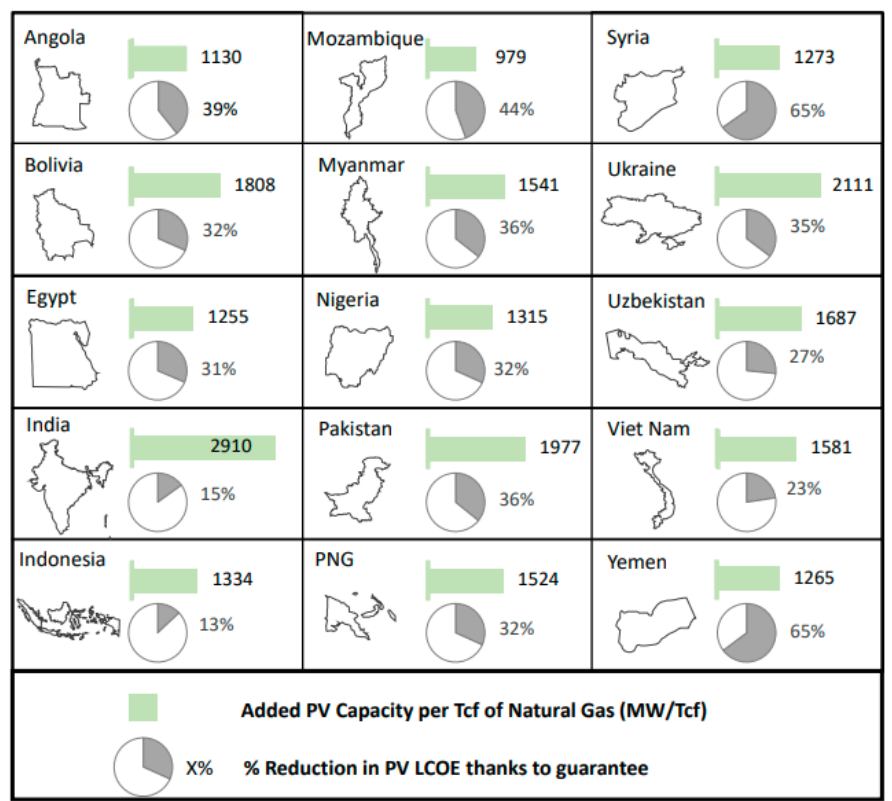
Figure 2. Protection levels for different values of 𝑟 across the considered countries.